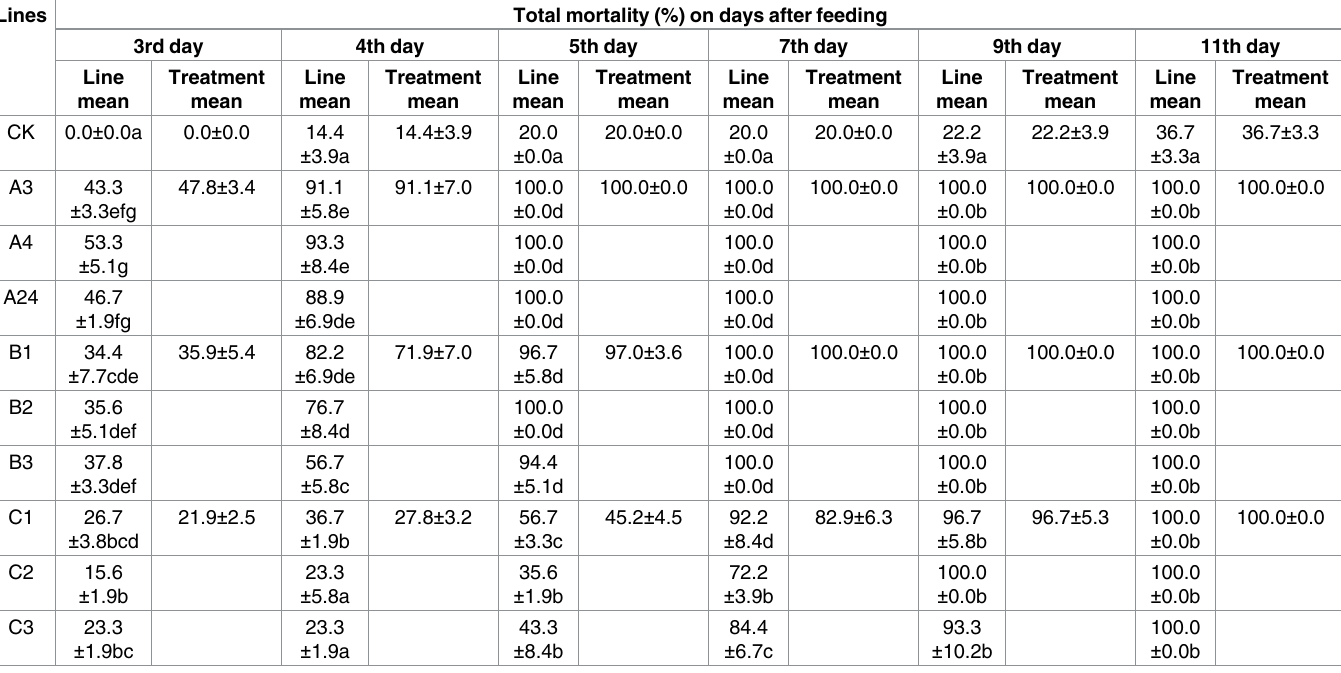
Table 4. Mortalities (%) of fall webworm larvae fed with leaves of three different transgenic lines. Lines Total mortality (%) on days after feeding 3rd day 4th day 5th day 7th day 9th day 11th day Line Treatment Line Treatment Line Treatment Line Treatment Line Treatment Line Treatment mean mean mean mean mean mean mean mean mean mean mean